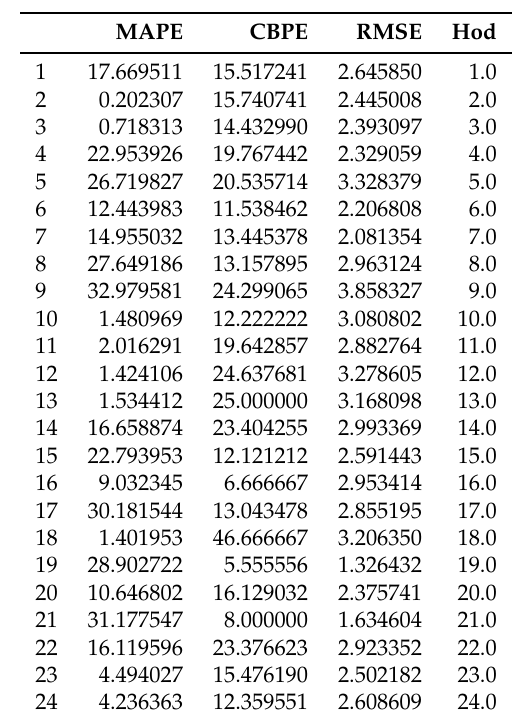
Figure 13. Sygic travel time data compared to Uber movement data. Table 2. MAPE, CBPE, and RMSE errors of Sygic data compared to Uber movement data for different hours of a